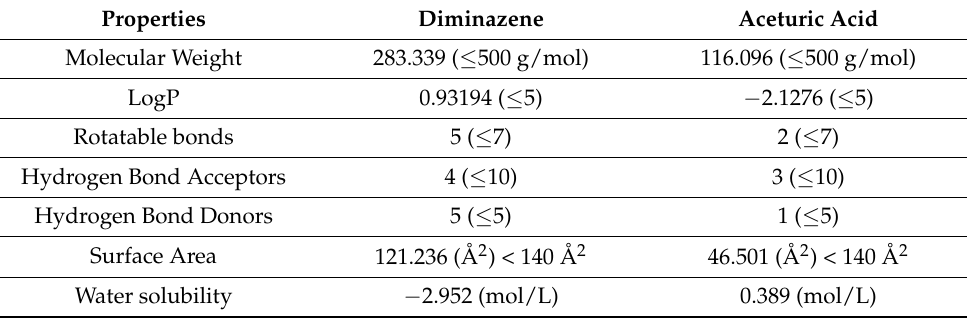
Table 6. The physicochemical parameters for compounds diminazene and aceturic acid.